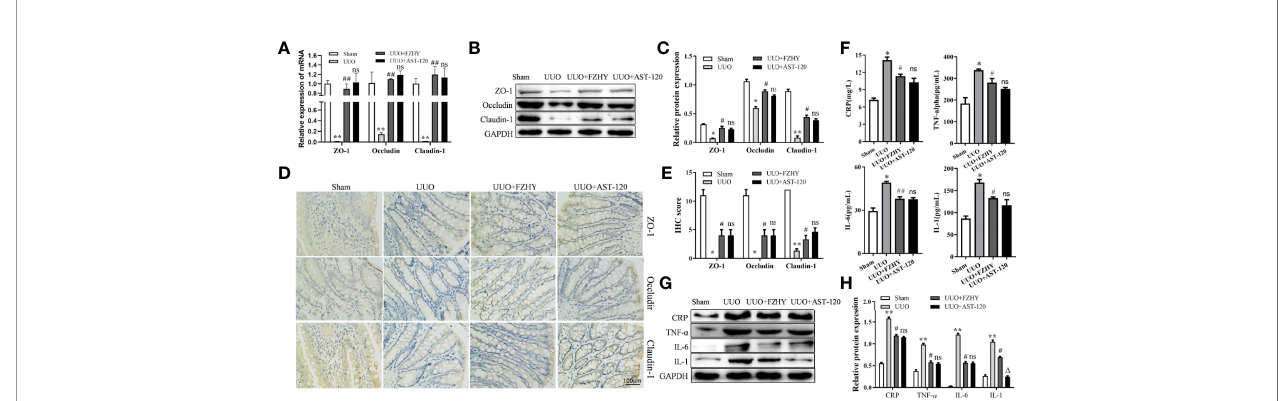
FIGURE 7 | Effect of FZHY on the integrity of intestinal tissue barrier in UUO rats. The mRNA (A) and protein (B, C) levels of the colon tissue tight junction proteins ZO-1, occludin, and claudin-1 were evaluated in the sham, UUO, UUO+FZHY, and UUO+AST-120 groups on day 7. The immunohistochemistry of ZO-1, occludin, and claudin-1 from kidney tissue sections was analyzed (D, E) . The secretion levels of the in fl ammation molecules including CRP, IL-1, IL-6, and TNF- a were measured in the sham, UUO, UUO+FZHY, and UUO+AST-120 groups on day 7 (F) . The protein levels (G, H) of the serum in fl ammation molecules in the sham, UUO, UUO+FZHY, and UUO+AST-120 groups on day 7. * P < 0.05, ** P < 0.01, the UUO group vs. the sham group; # P < 0.05, ## P < 0.01, the UUO+FZHY group vs. the UUO group; D P < 0.05, the UUO+AST-120 group vs. the FZHY-treated group. ns, not signi fi